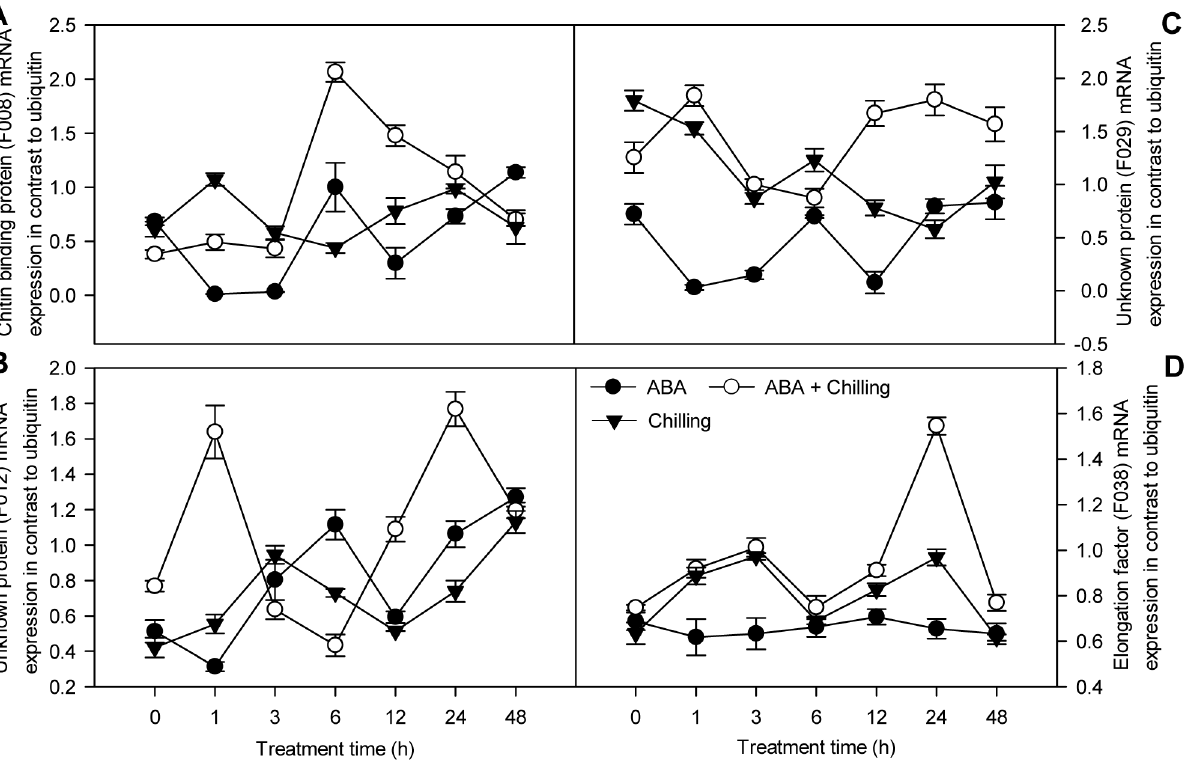
Figure 5. Analysis of mRNA expression of four genes using qPCR found upregulated with SSH. Total RNA was extracted from pepper leaves with ABA spray or water, subsequently 72 h after foliar application exposed for 48 h to 6 u C. SE was calculated based on three biological replicates. Closed circle: ABA-pretreated samples under room temperature; open circle: ABA-sprayed samples prior to chilling stress; triangle down: water-sprayed samples prior to chilling stress. The level of ubiquitin was used as an internal reference gene.